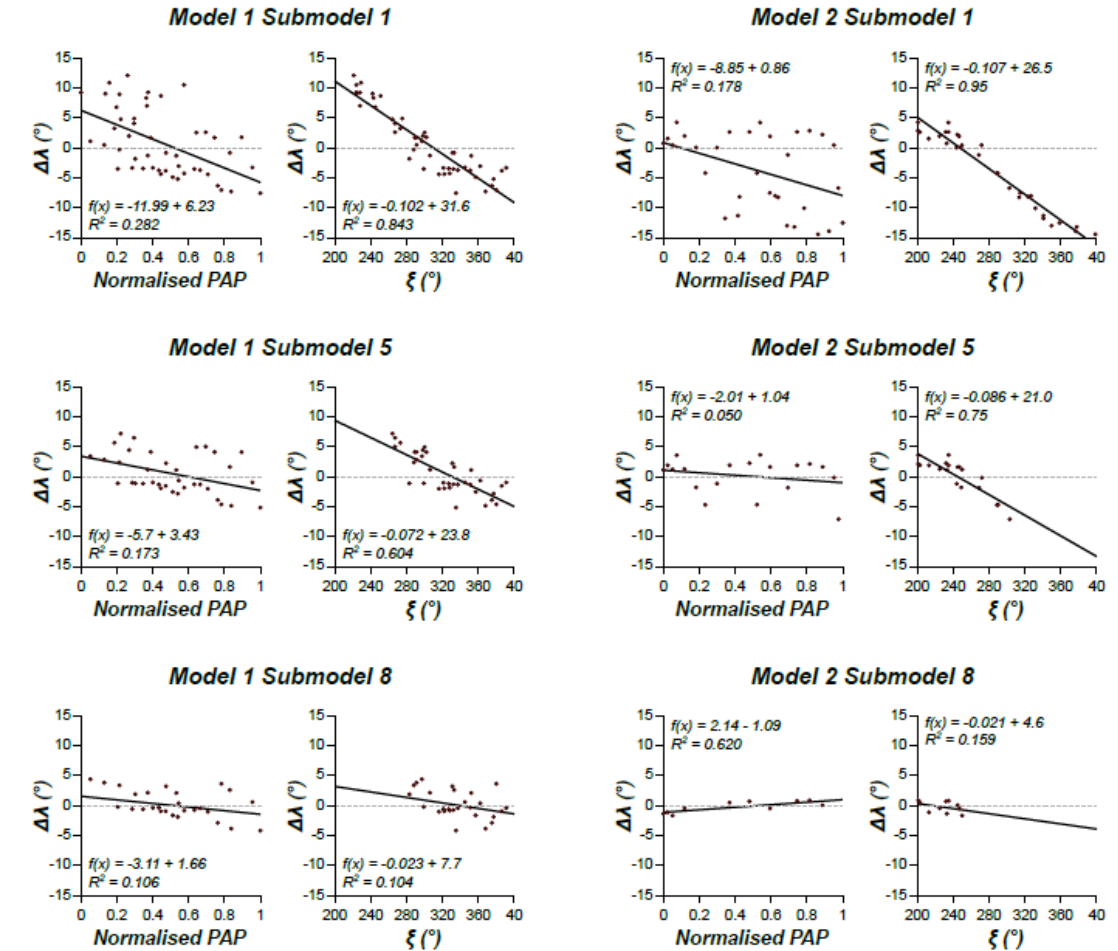
Figure 7. Graphs for three sub-models of Model 1 and 2, showing the relationships between the position of (normalised position along the diagonal path shown in Figure 5) and view direction of photographs vs. the angular di ff erence between the estimated-and-rotated ξ and ρ and the measured ones (i.e., Δλ = (Δξ + Δρ)/2).